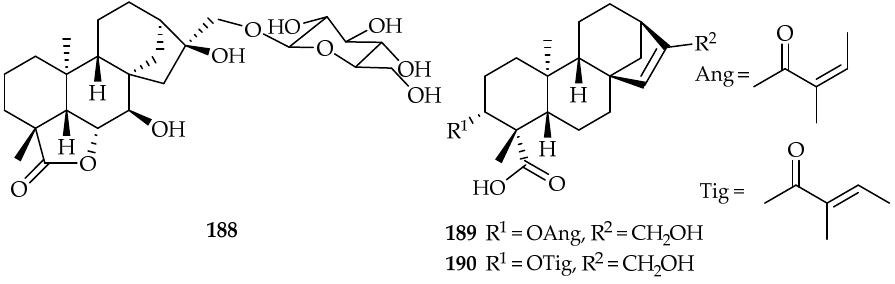
Figure 77. Structures of pharboside H 188 [122] and compounds 189–190 [123].